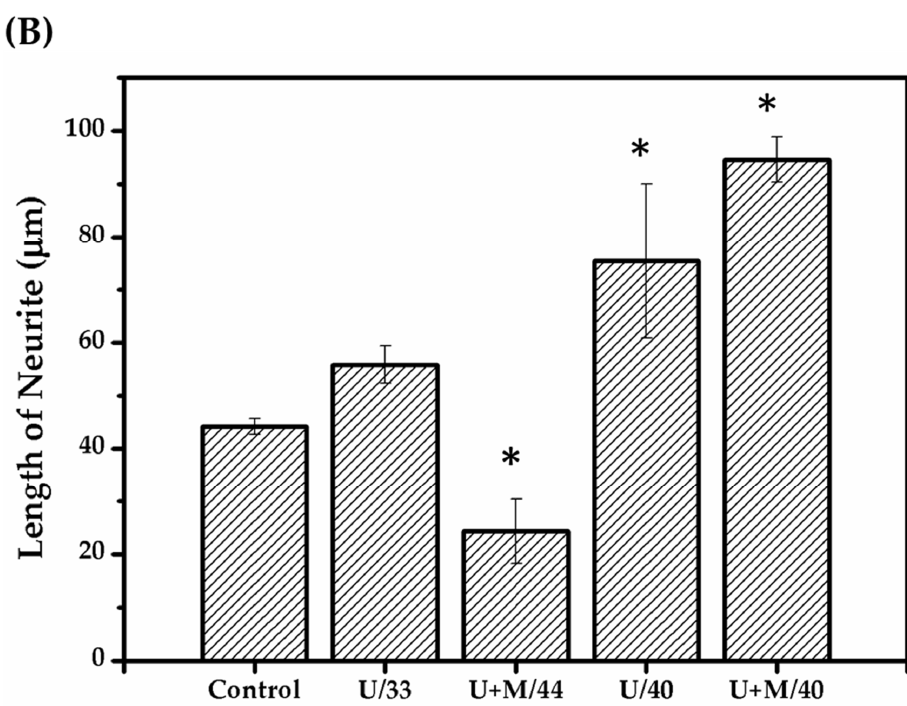
Figure 5. Fluorescence staining and nerve outgrowth analysis. ( A ) Fluorescent images of ultrasound-treated cells combined with the warming biomaterial to enhance nerve outgrowth. Non-treated cells are designated as the control, U / 33 is ultrasound-treated cells at 33 ◦ C, U + M / 44 is ultrasound-treated cells combined with warming biomaterial at 44 ◦ C, U / 40 is ultrasound-treated cells at 40 ◦ C, U + M / 40 is ultrasound-treated cells combined with warming biomaterial at 40 ◦ C. Scale bar = 50 μ m. ( B ) Quantification of neurite length by fluorescent image. * p < 0.05 compared with control group.